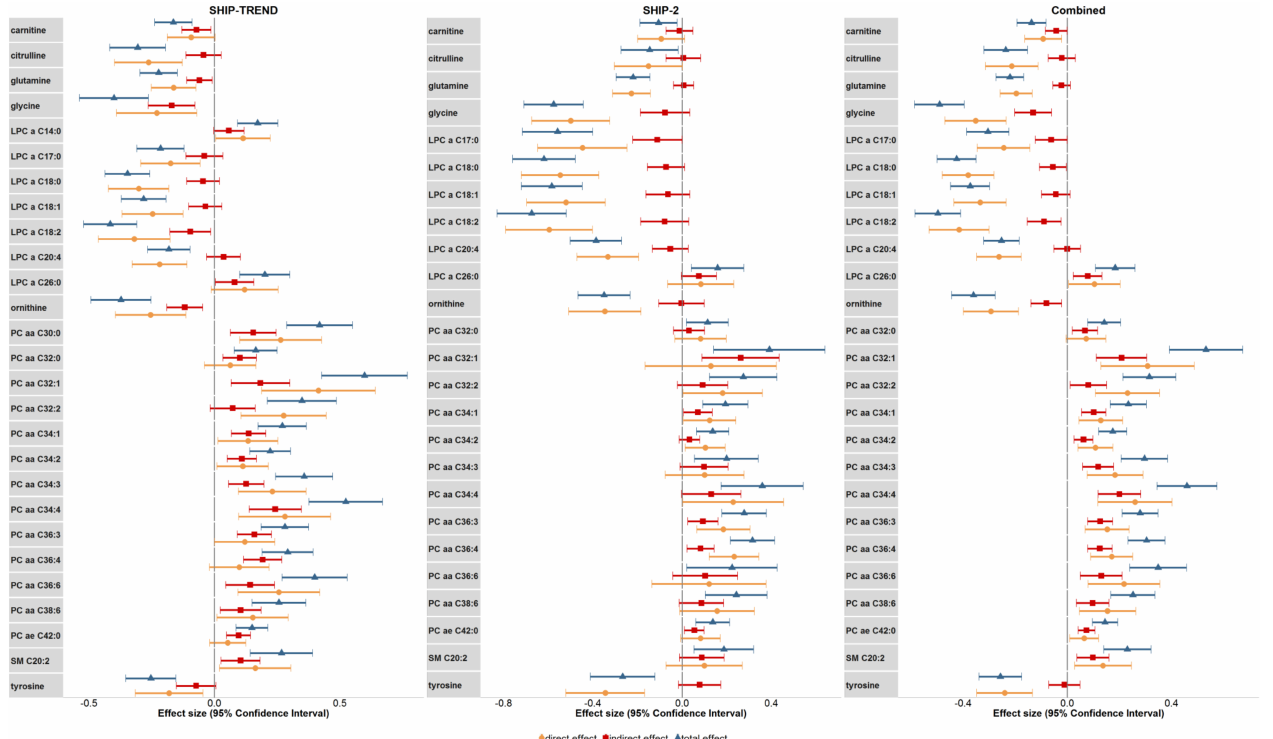
Figure 3. Statistical mediation of the OC effect on metabolites by cortisol. Analyses were adjusted for age, time of blood sampling, fasting time (restricted cubic splines), waist circumference, white blood cell count, red blood cell count, thrombocytes count and cystatin C concentrations (and cohort for the combined sample). Direct effect = OC effect on metabolites. Indirect effect = OC effect mediated through cortisol effect. Total effect = direct + indirect